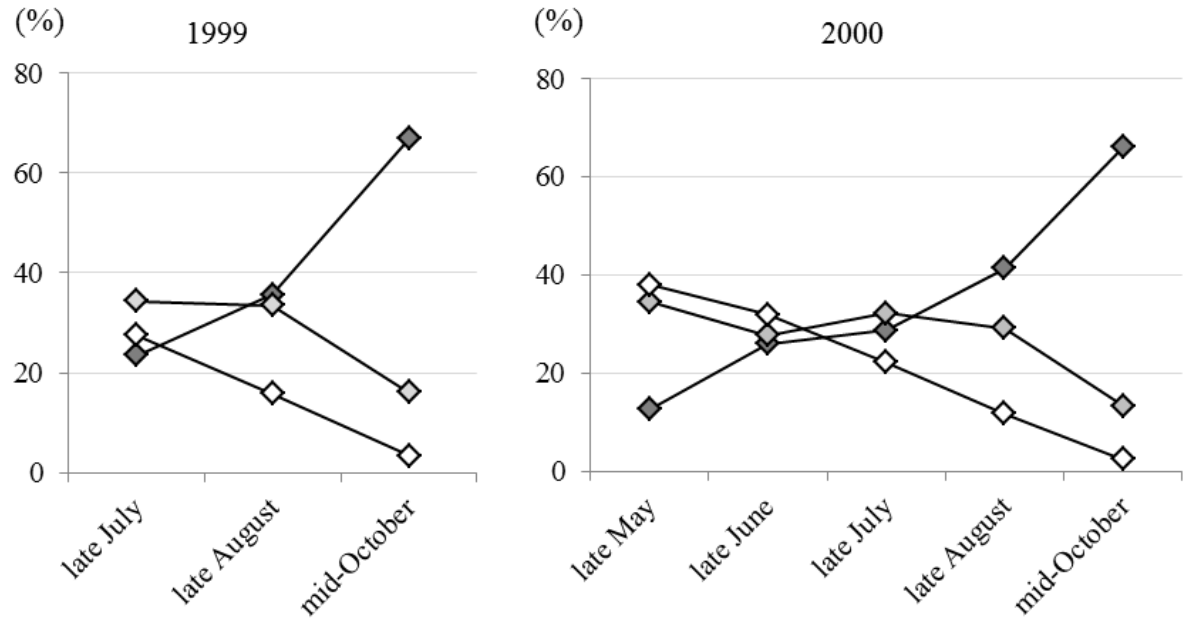
Figure 2 Average proportion (% of the total pasture area) of patches of different grazing intensity during the grazing season in the first year (1999, left) and the second year (2000, right) of the study. Dark grey: proportion of heavily grazed patches; light grey: moderately grazed; empty diamonds: